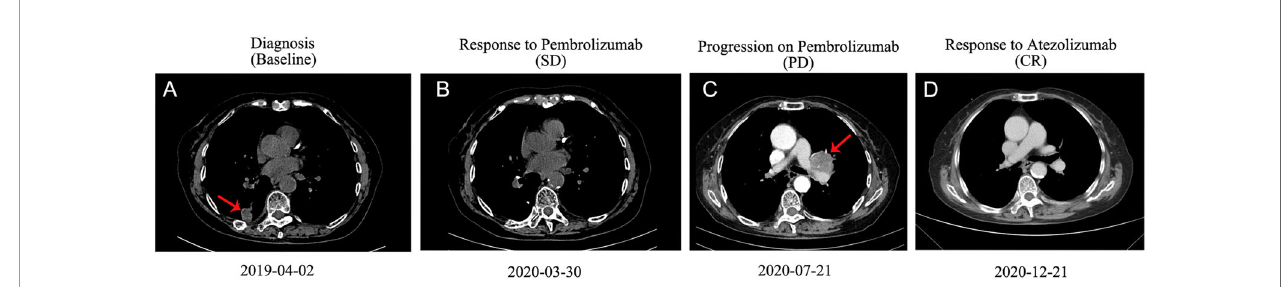
FIGURE 1 | Computed tomography (CT) scans of the thorax of the patient. (A) CT scan before the treatment. (B) Image of the best response of pembrolizumab therapy. (C) Image of progression of pembrolizumab therapy and before atezolizumab therapy. (D) Image of best response of atezolizumab therapy. CR, complete response; SD, stable disease; PD, progressive